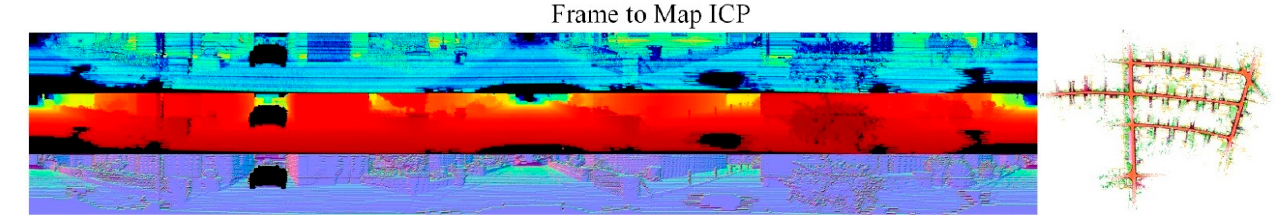
Figure 8. Schematic diagram of frame-to-map ICP.